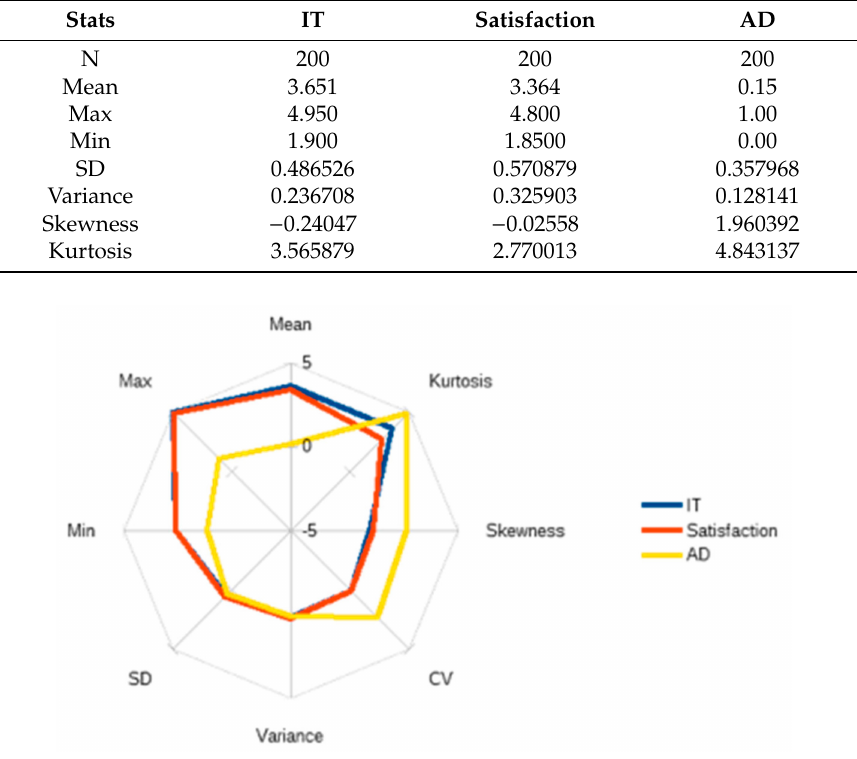
Figure 1. Summary statistics graph ( n = 200).